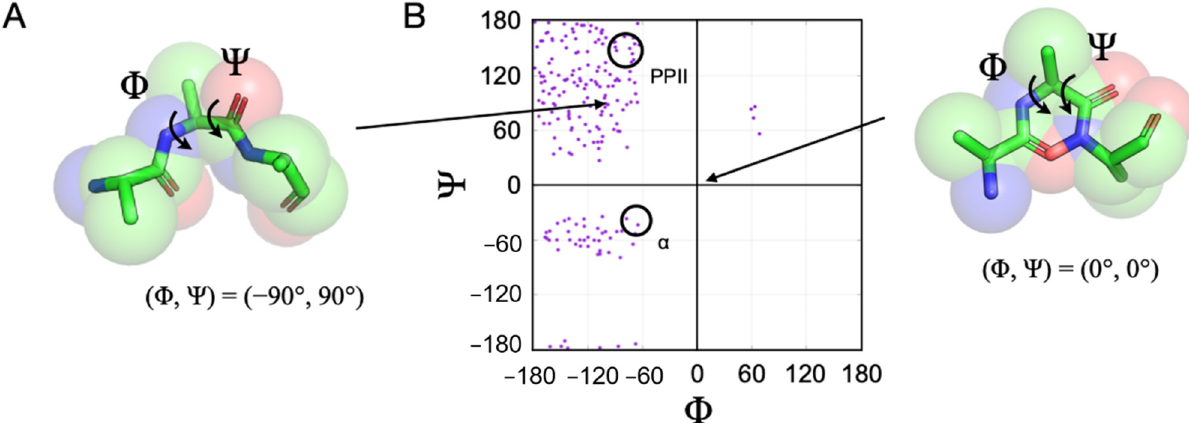
Figure 1. Sterically allowed backbone conformations in polypeptides. ( A ) Peptide backbone dihedral angles, Φ and Ψ . ( B ) Ramachandran plot of allowed Φ , Ψ for the central residue in a poly-alanine tripeptide, calculated from structures generated computationally using a hard sphere collision (HSC) model [48,49] and the “normal” atom pair distances from Ramachandran et al. [47]. Approximately 9000 random structures were generated to find 200 sterically allowed configura- tions. Highlighted by the circled areas are Φ , Ψ regions corresponding to the PPII and α -helix backbone conformations, as indicated.